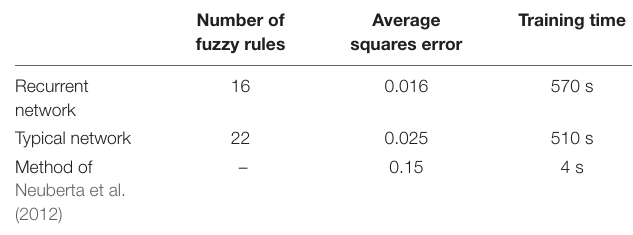
TABLE 1 | Specifications of networks